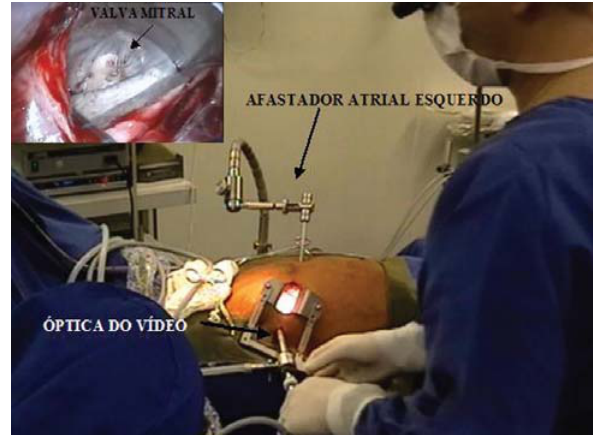
Fig. 2 - Aspecto do campo operatório, demonstrando afastador atrial esquerdo, minitoracotomia e local da ótica de vídeo. Em detalhe, no canto superior esquerdo, vista do interior do átrio esquerdo via videotoracoscopia